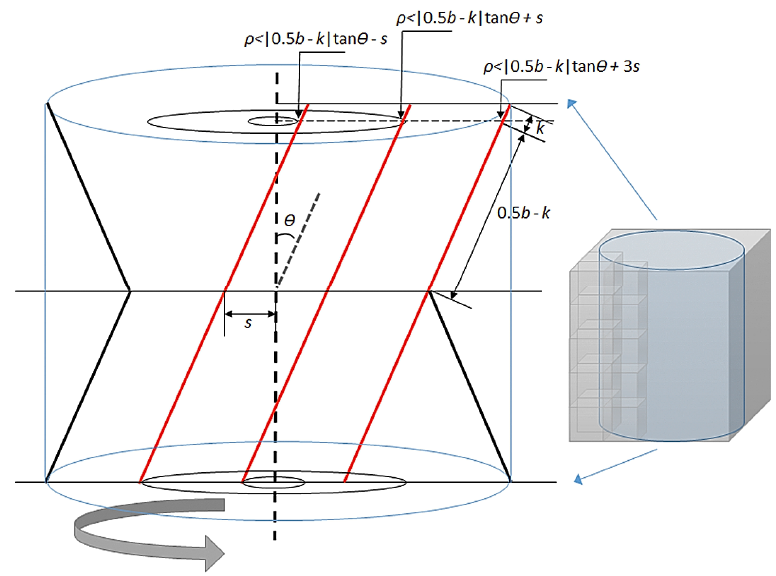
Figure 3. 3 ‐ D directional filter: a cube composed of voxels in the right; Mathematic expressions about the filter geometry and structure are noted